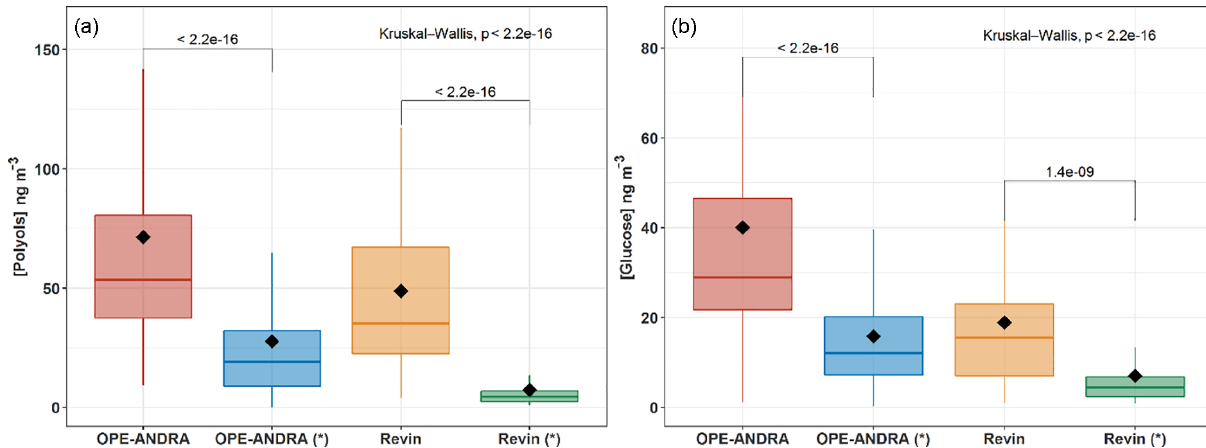
Figure 5. Box plots of mass concentrations of polyols (a) and glucose (b) in PM 10 and PM 2 . 5 (with symbol ∗ samples). Black markers inside each box indicate the mean concentration value, while the top, middle, and bottom lines of the box represent the 75th, median, and 25th percentile, respectively. The whiskers at the top and bottom of the box extend from the 95th to the 5th percentile. The number of samples was N = 123 for OPE-ANDRA and N = 87 for Revin. Statistical differences between average mass concentrations were analyzed with the Kruskal–Wallis methods ( p< 0 . 05).